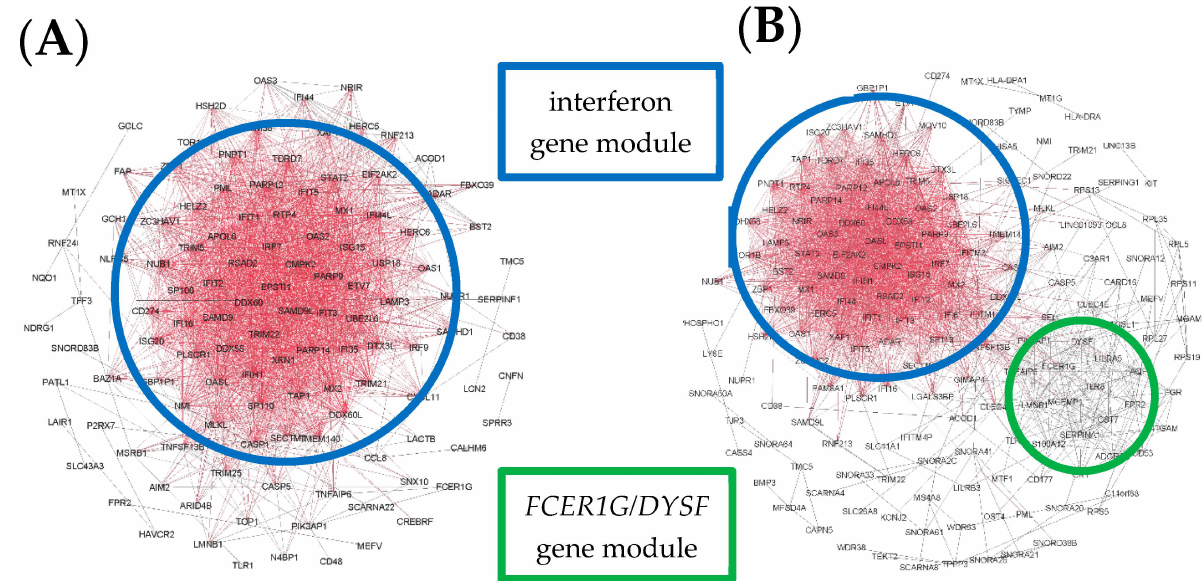
Figure 4. Illustrative examples of personal gene network structures generated in Gephi for representative subjects from Cluster A. Example ( A ) shows an interferon-dominated network, whereas Example ( B ) shows a network with two prominent modules. Red indicates highly connected genes (“hubs”) and black denotes genes with few connections.